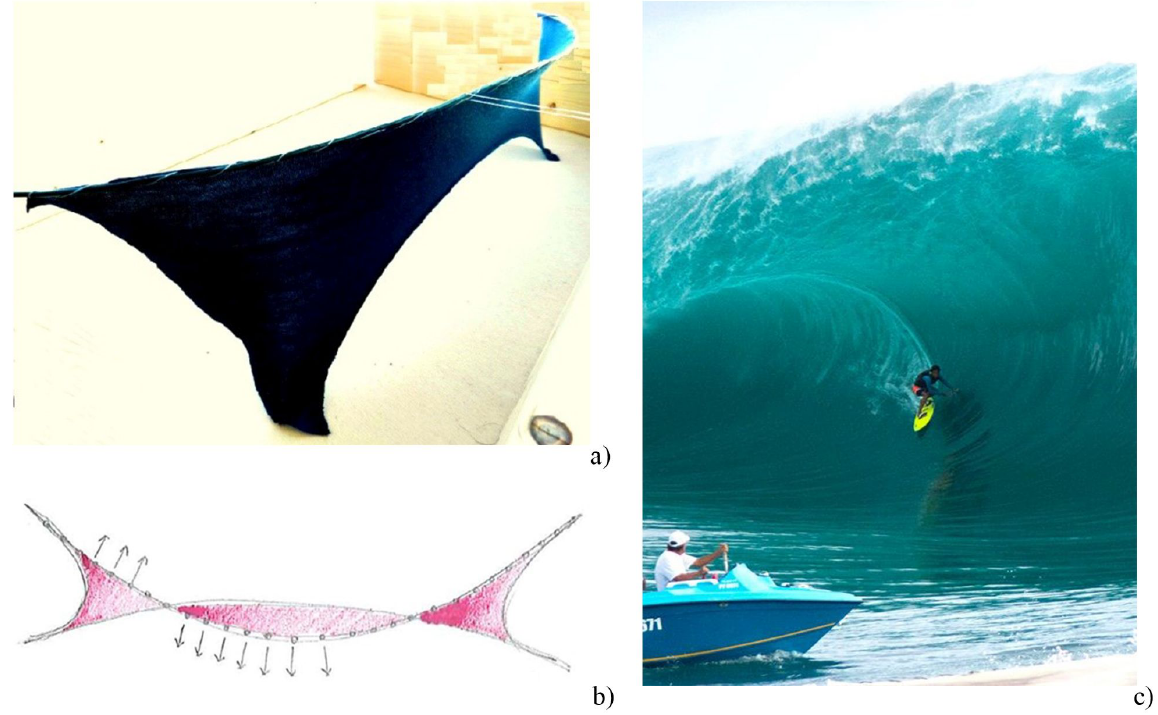
Figure 12: Initial form-finding of the curved shell-supported footbridge: (a) using a fabric physical model; (b) with a hand-made sketch; (c) referring to the shape of a sea wave